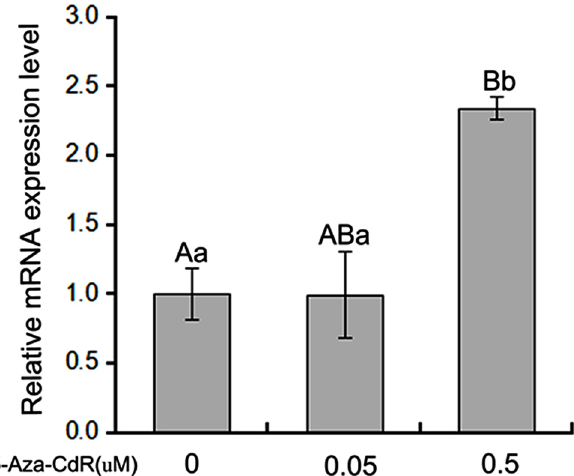
Fig 5. mRNA expression of b Boule in BMECs treated with 5-Aza-dC. mRNA expression was detected in treated cells but not in untreated cells by qRT-PCR. All experiments were performed three times. The bar above the histogram indicates the SEM. Different uppercase letters denote significant differences between different groups with a significance level of P < 0.01. Different lowercase letters denote significant differences between different groups with a significance level of P <